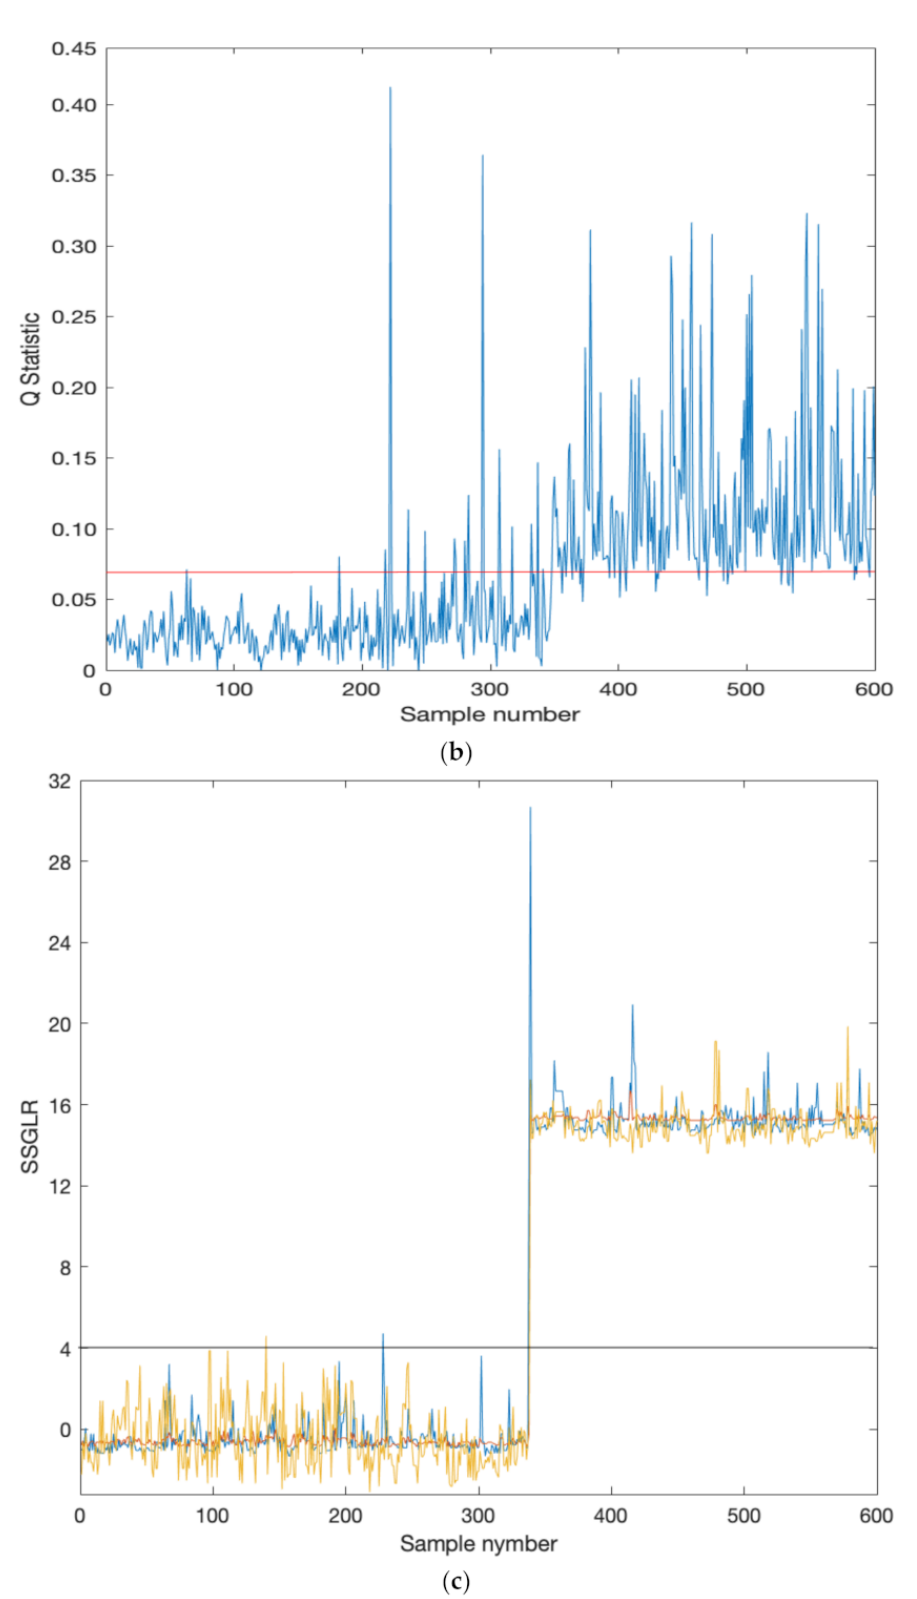
Figure 10. ( a ) KPCA-KDE-based T 2 chart fault detection results in quality pertinent; ( b ) KPCA-KDE- based Q chart fault detection results in quality pertinent; ( c ) KPCA-KDE-based SSGLR chart fault detection results in quality